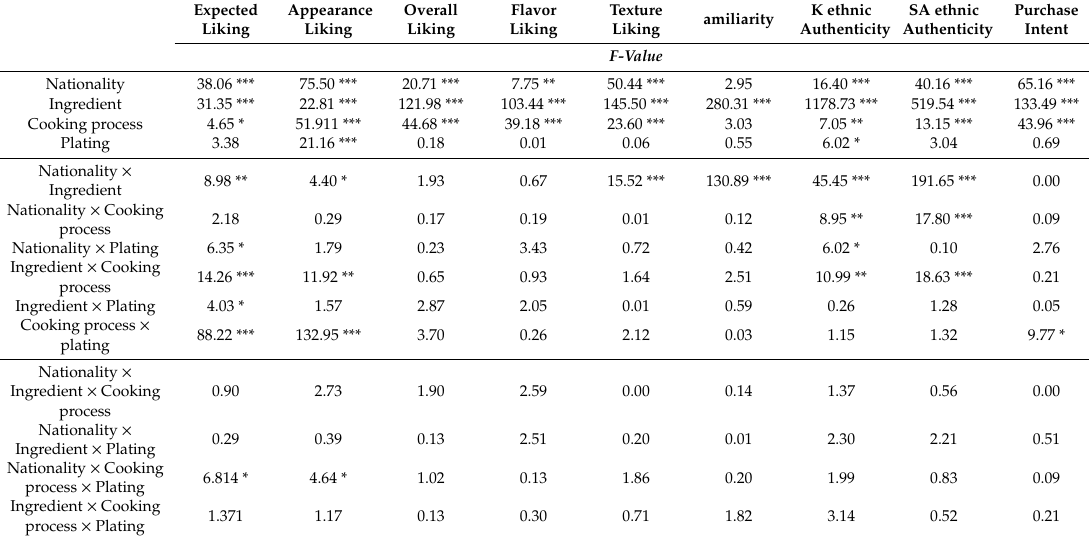
Table 3. F-values associated with the e ff ect of main factors and their 2-way and 3-way interactions on liking ratings, degree of familiarity, perceived Korean (K) and Southeast Asian (SA) ethnicity, and purchase